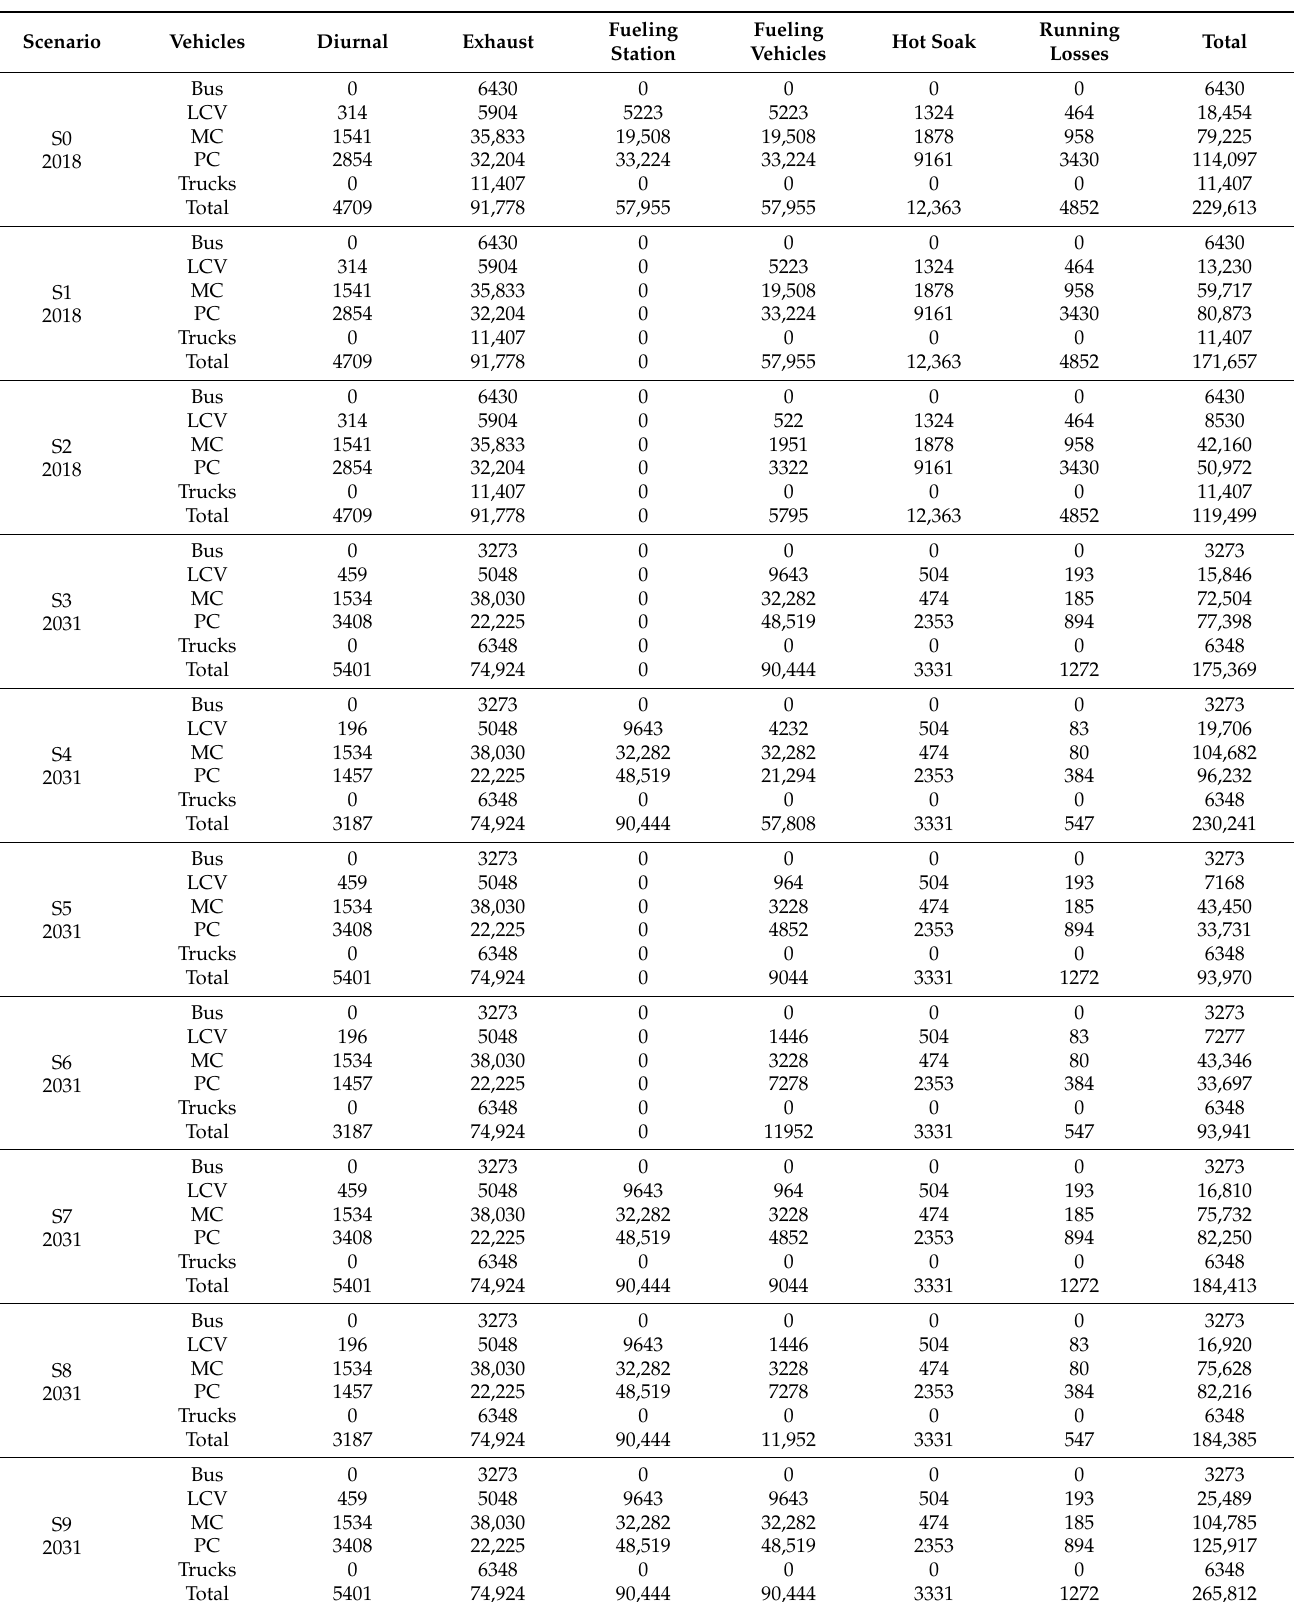
Table 2. NMHC emissions by type of vehicle and scenario in Brazil